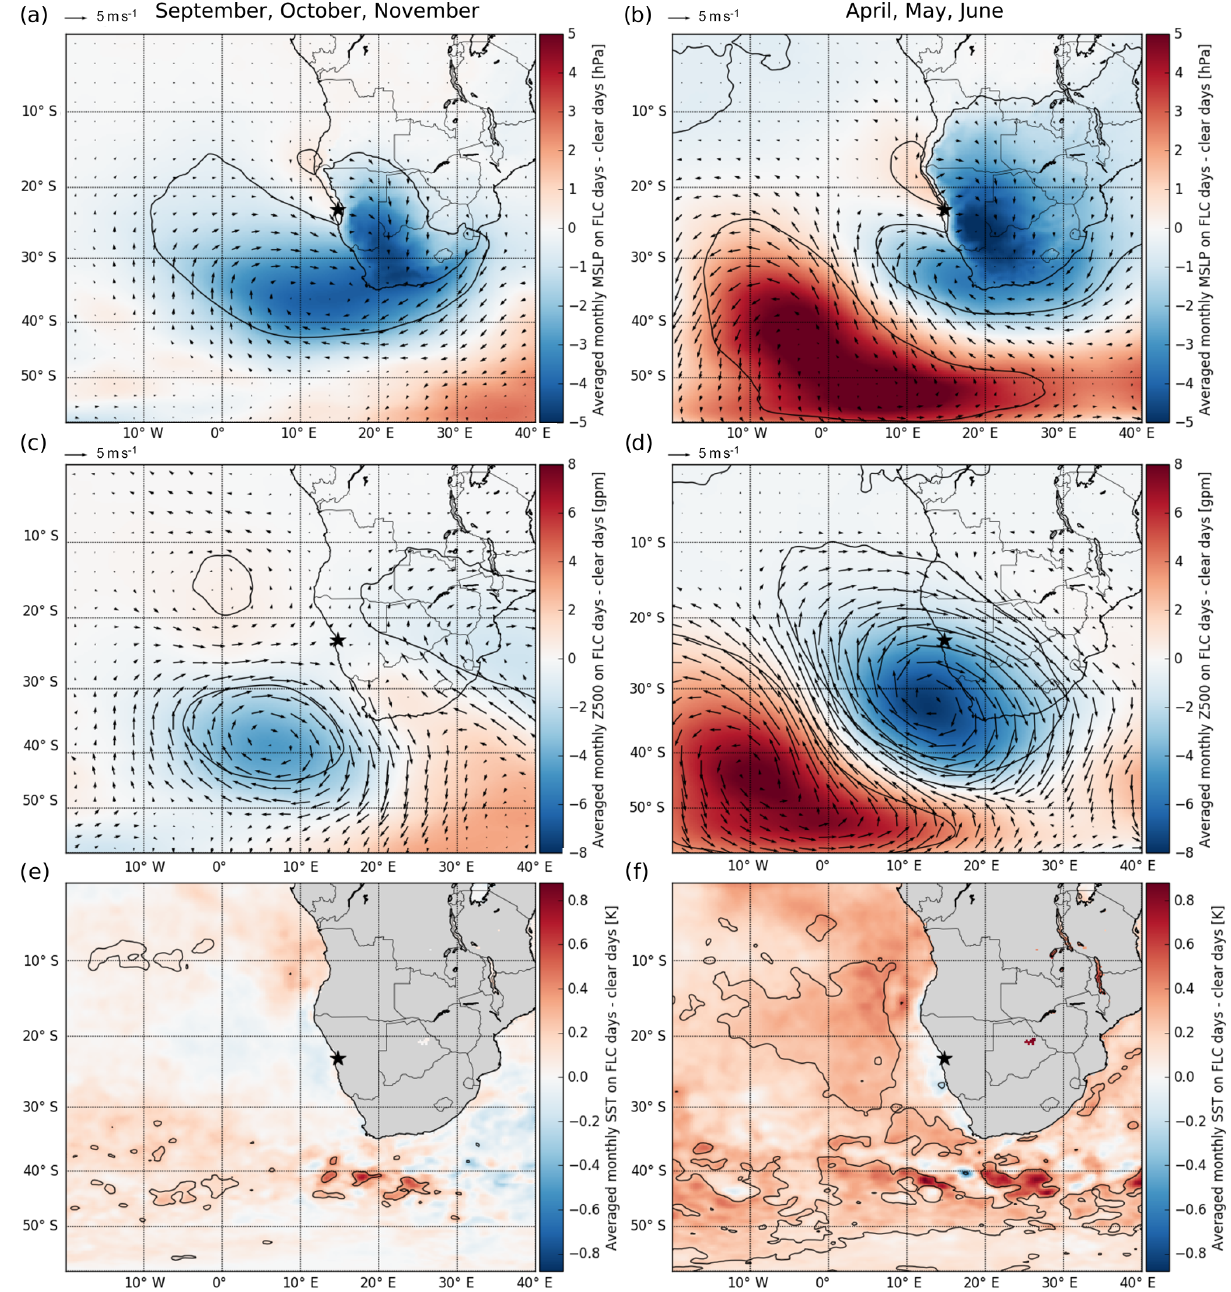
Figure 4. Mean of monthly average differences (FLC days − clear days) during (a, c, e) SON and (b, d, f) AMJ of (a, b) MSLP, (c, d) Z500, and (e, f) SST for the time period 2004–2017. Contours mark significant differences as in Fig. 3. Wind anomalies at (a, b) 10m and (c, d) 500hPa are superimposed as